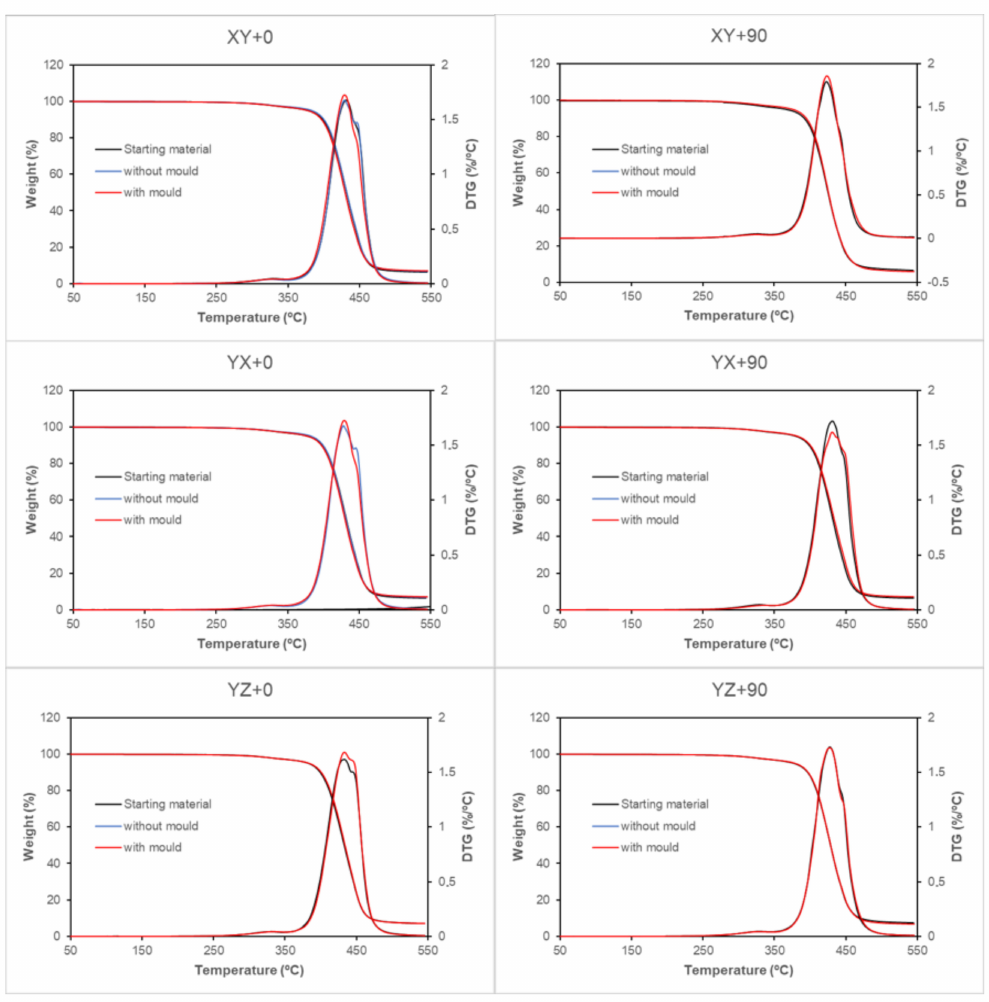
Figure 9. TG/DTG curves of ABS samples at 10 ◦ C min − 1 in nitrogen atmosphere. Specimens comparison before thermal process, after thermal process with mould and after thermal process without mould for XY + 0, XY + 90, YX + 0, YX + 90, YZ + 0 and YZ + 90 samples.